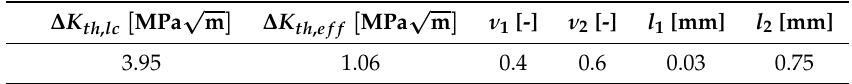
Table 4. Parameters resulting from crack propagation tests in position A and B for a probability of occurrence of P Occ =